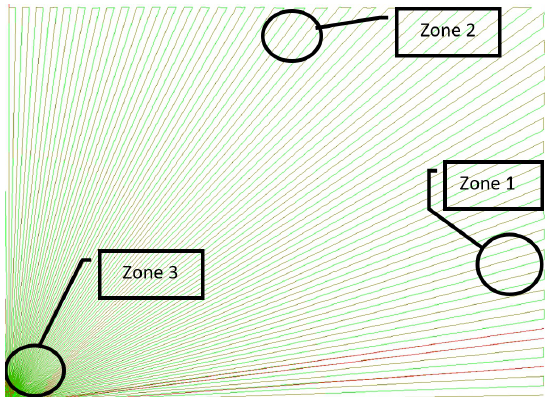
Figure 9. Measurement zones for machined surface roughness for EXP 2 (SR2+SF2)